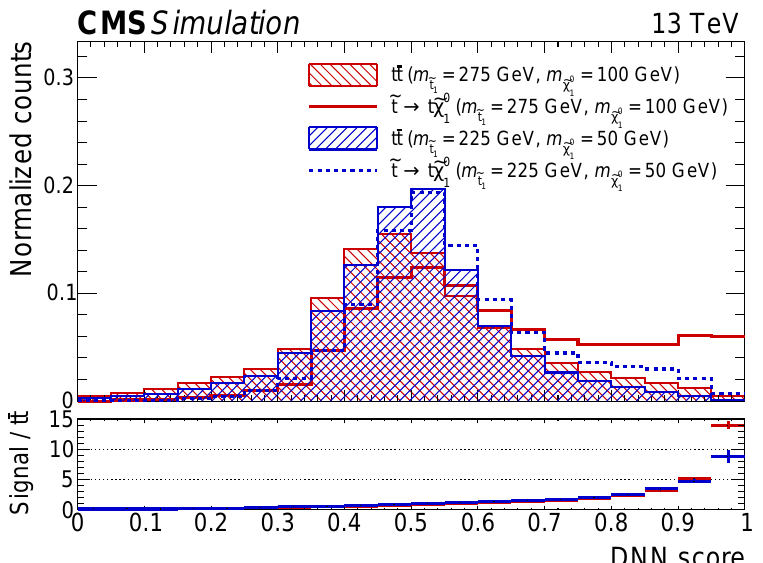
Figure 10. Normalized distribution of DNN score comparing the signal and the background (t¯t events) for two hypotheses of top squark and neutralino masses